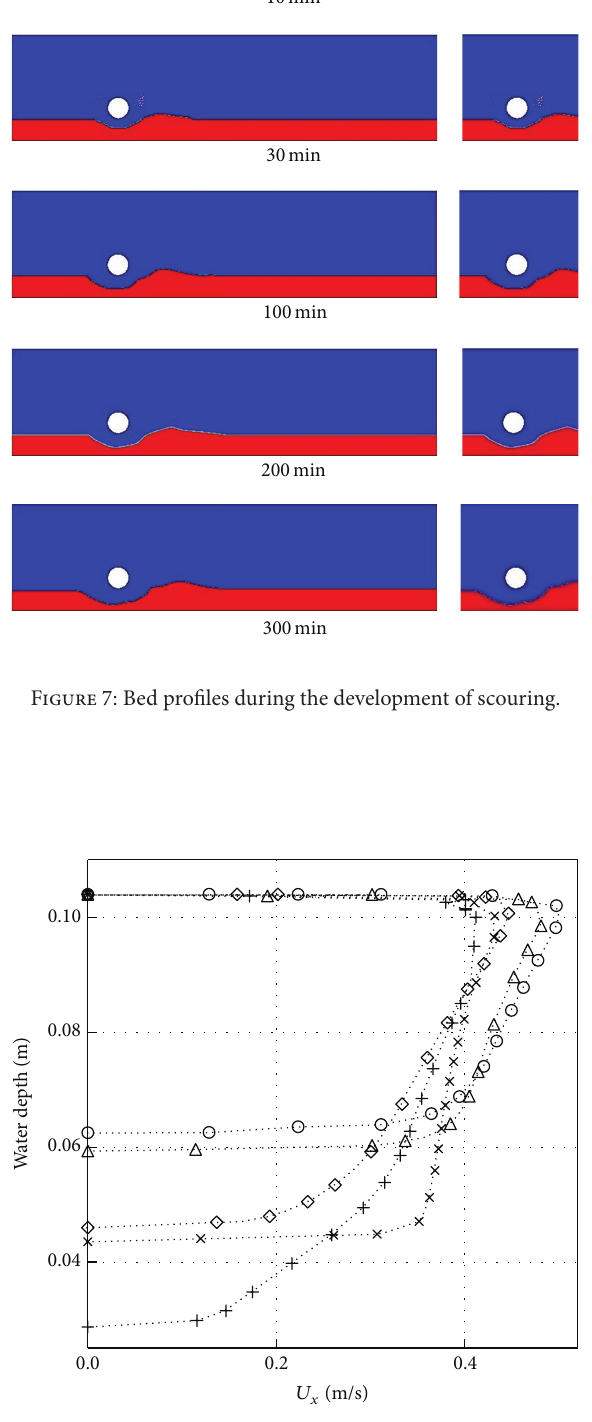
Figure 8: Horizontal velocity profile ( 𝑈 𝑥 ) in the gap at (𝑋/𝐷 = 0) and at different scour gaps, I 10min, △ 30min, ⬦ 100min, × 200 min, and + 300